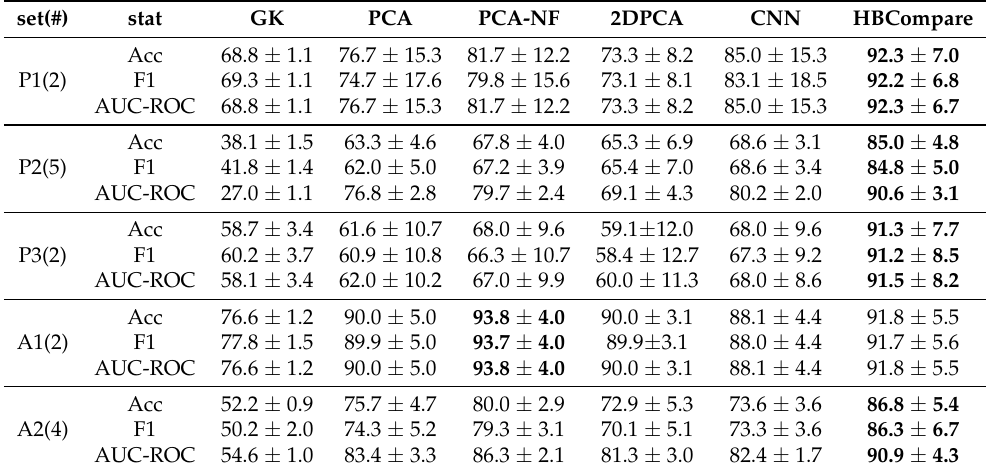
Table 3. Average classification accuracy and F1 score (avg ± std) of compared methods using only hydrogen bond topology, across all cross-validation folds. The set ( # ) column indicates the dataset and the number of subfamilies it contains. The stat column indicates rows with either classifier accuracy or F1 score. The highest value in each row is